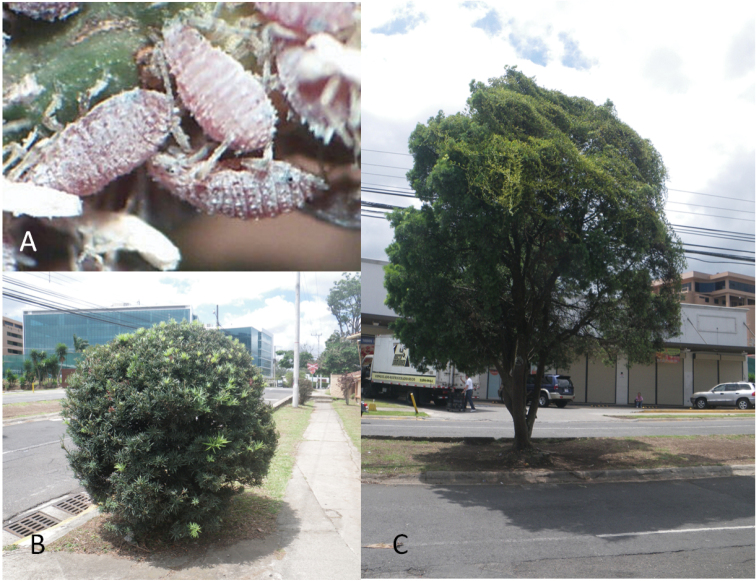
ANeophyllaphisvaricolor Miller & Halbert, apterous individuals from Costa Rica BPodocarpuschinensis Wall. ex J.Forbes, and CPodocarpusfalcatus (Thunb.) Mirb.